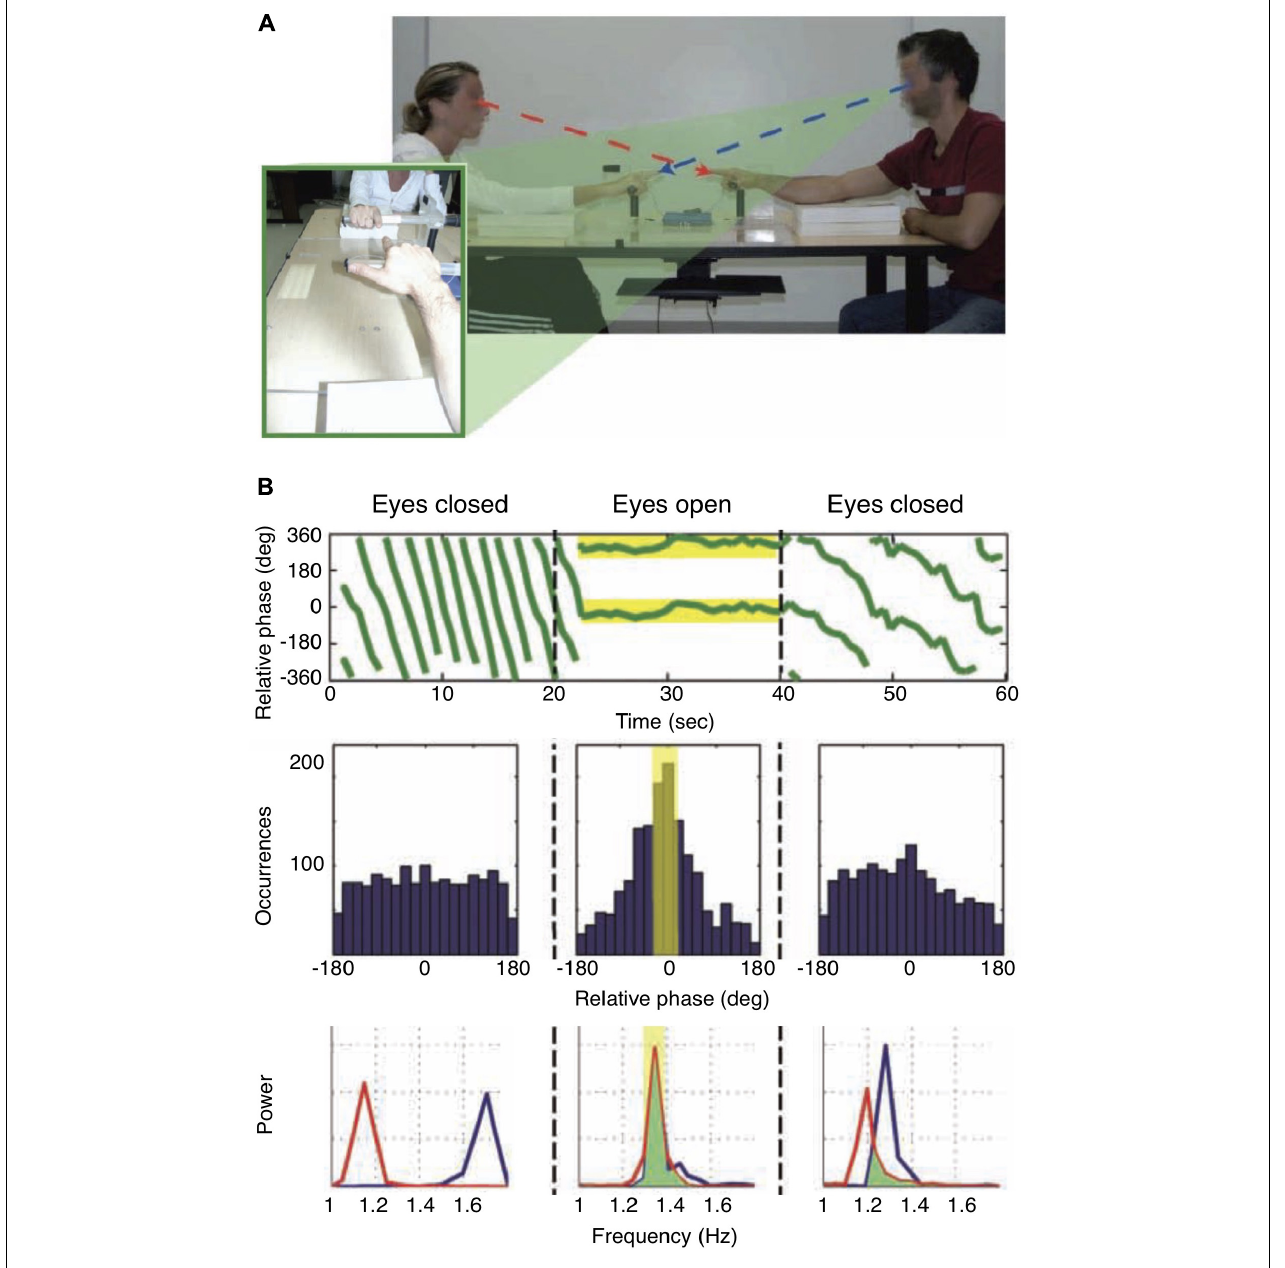
FIGURE 3 | Coordination dynamics in social interaction. (A) Experimental setup. Participants were seated opposite to each other and instructed to move their index finger up and down continuously, either with eyes open or eyes closed in separate periods. Importantly, no specific instructions about the coordination of the finger movements were given. (B) (Top) Relative phase of the finger movements, indicating synchrony when participants had their eyes open and were viewing each other’s movements. (Middle) Occurrence of relative phase lags of movements. With eyes open, zero phase lag dominated the distribution. (Bottom) With eyes open, participants adopted the same movement frequency; of note, movement frequencies remained similar when participants closed their eyes again. Modified from Oullier et al.